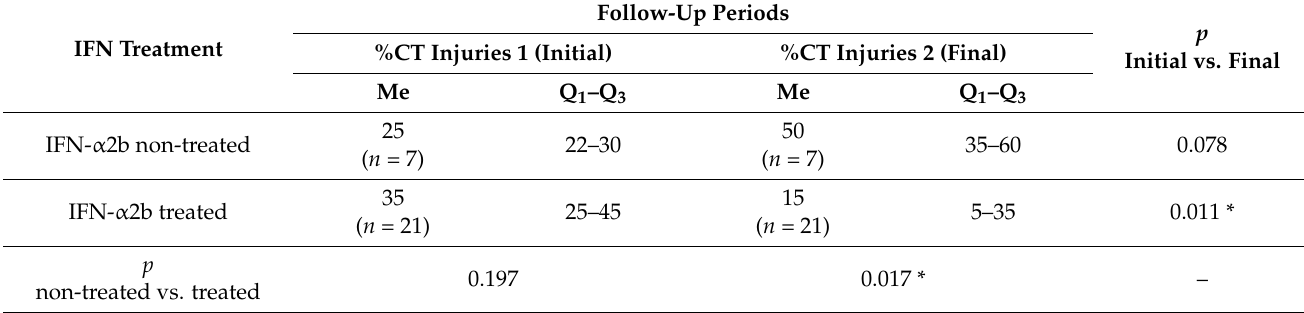
Table 2. Analysis of the level of % CT damage before and after IFN- α 2b